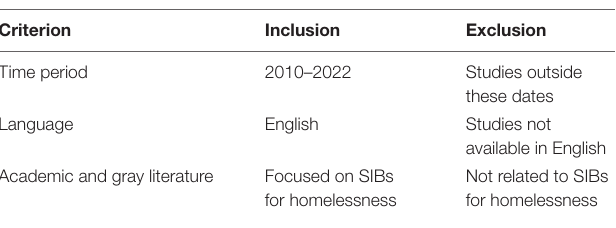
TABLE 1 | Eligibility